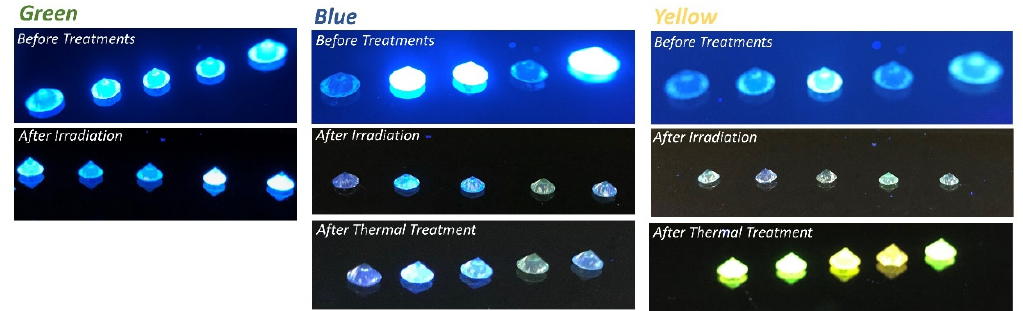
Figure 4. Long-wave UV fluorescence photographs of the diamonds: pre- and post-irradiation and, for blue and yellow, post-thermal treatment. If green after the irradiation treatment, some diamonds’ fluorescence changed to white; if blue after the irradiation treatment, some diamonds’ fluorescence changed to green-yellow, and after annealing, there was no change in fluorescence; if yellow after the irradiation treatment, 4/5 diamonds showed no fluorescence, but, after thermal annealing, all diamonds showed strong yellow